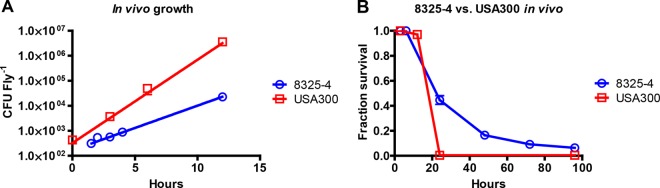
In vivo growth rates and killing of flies of the two bacterial isolates. (A) The in vivo growth rate of USA300 was 54 min, and that of strain 8325-4 was 104 min, demonstrating a difference in proliferation. Three flies were homogenized and serial dilutions were made in PBS before plating on S. aureus-selective MSA to determine the number of CFU. (B) USA300 killed close to 100% of infected flies within 24 h, while isolate 8325-4 killed approximately 50% of flies within 24 h of infection (P < 0.0001). Minor differences in the starting inoculums were observed (see Materials and Methods). Survival data are compiled results from all in vivo kill rate experiments presented in Fig. 2 and 4.